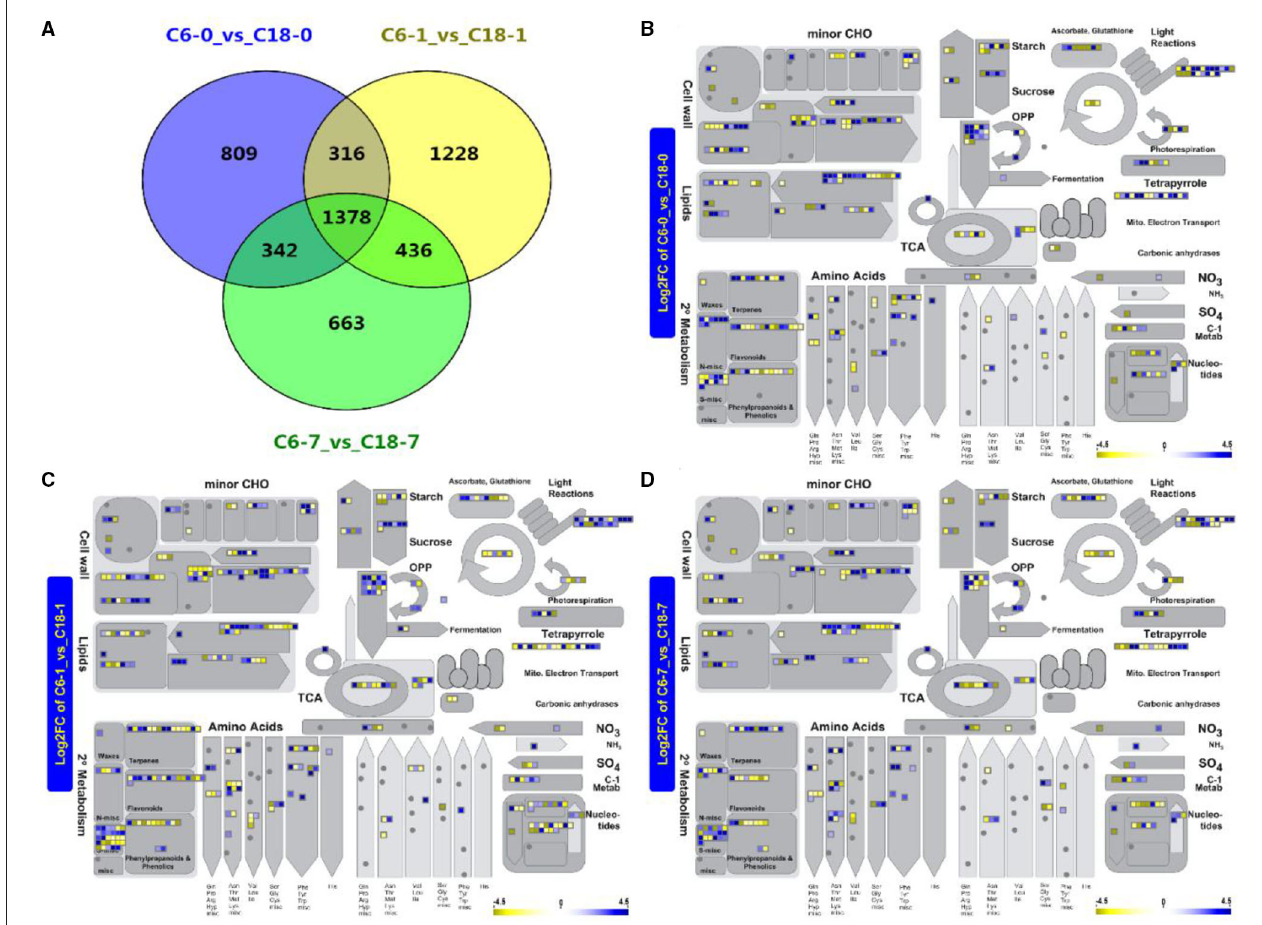
FIGURE 4 | (A) Venn diagram showing the shared and common differentially expressed genes (DEGs) for the same time points between C6 and C18 varieties. (B–D) Metabolism overview of all DEGs at 0 (CK), 1, and 7 days of stress between both cultivars revealed by the MapMan pathway annotator, respectively. (B) A total of 2,725 of the 2,845 data points were mapped (some of the data points may be mapped multiple times to different bins), and 363 genes are visible in data points; (C) A total of 3,297 of the 3,358 data points were mapped (some of the data points may be mapped multiple times to different bins) and 449 genes are visible in data points; (D) A total of 2,713 of the 2,829 data points were mapped (some of the data points may be mapped multiple times to different bins) and 360 genes are visible in data points. Boxes in a blue or yellow color mean significantly up- and downregulated genes, respectively. CHO, carbohydrate; OPP, oxidative pentose phosphate; TCA, tricarboxylic